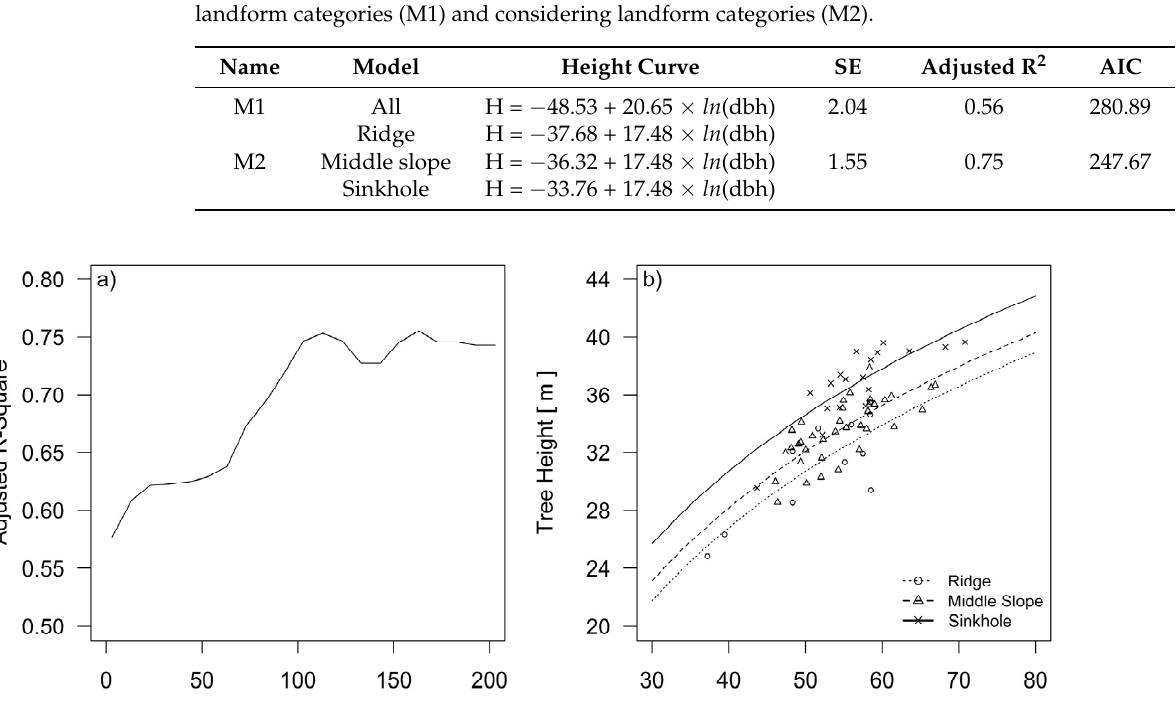
6 Figure 6. Changing the adjusted R-Squared in the iterative process of modelling the growth site size according to the height differences of silver fir in the three groups of the landform categories ( a ). Height curves of the silver fir trees in the three landform categories after the final selection of the scale and delineation of landform categories ( b